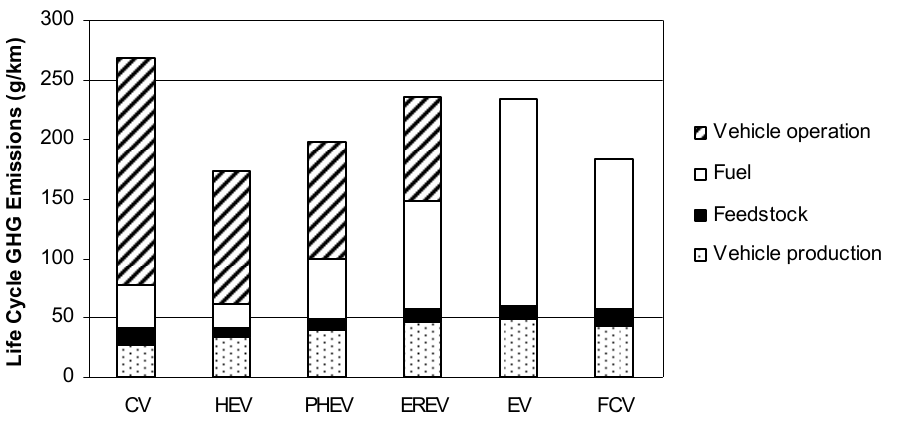
Figure 4. LCA of GHG emissions for a conventional vehicle and various advanced